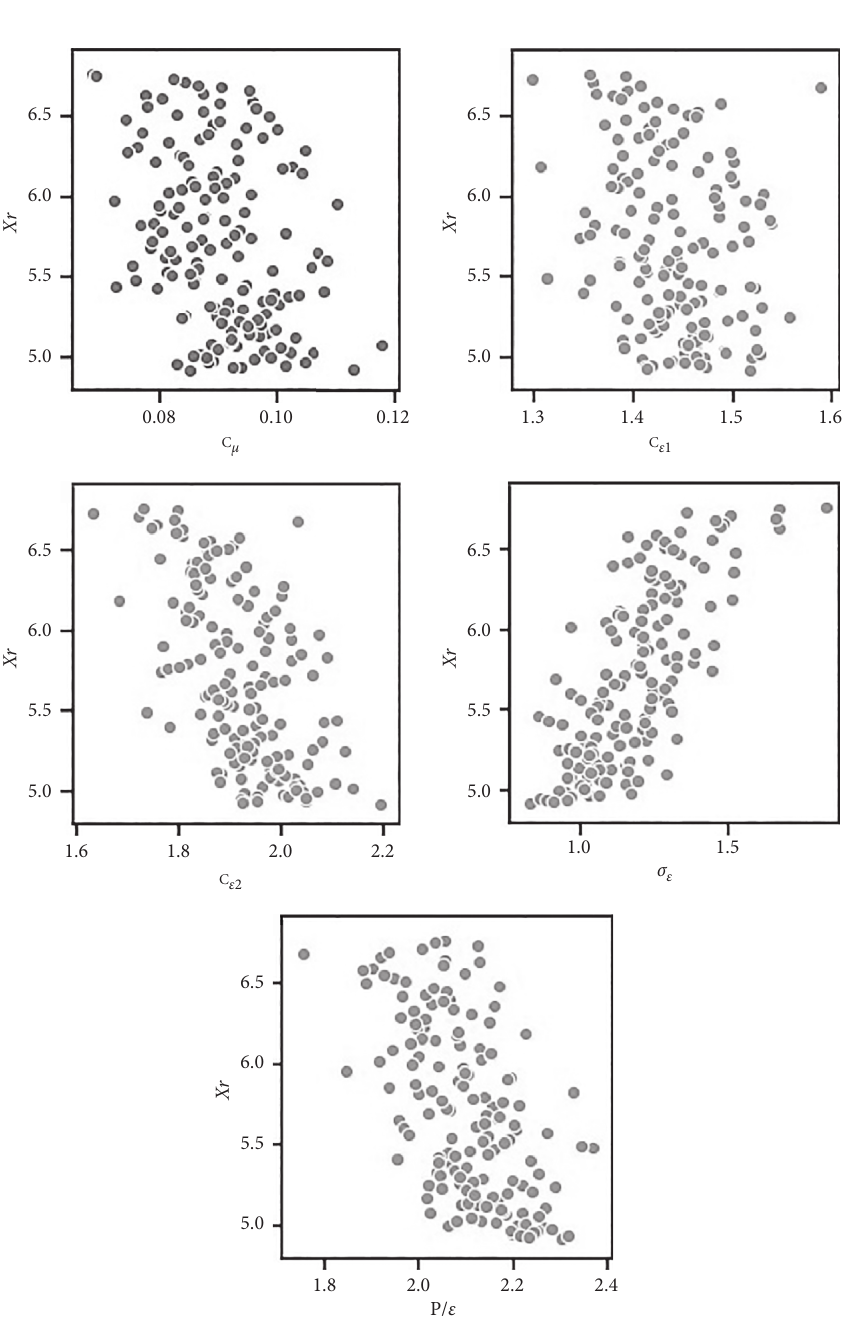
Figure 9: Scatter diagrams of Xr